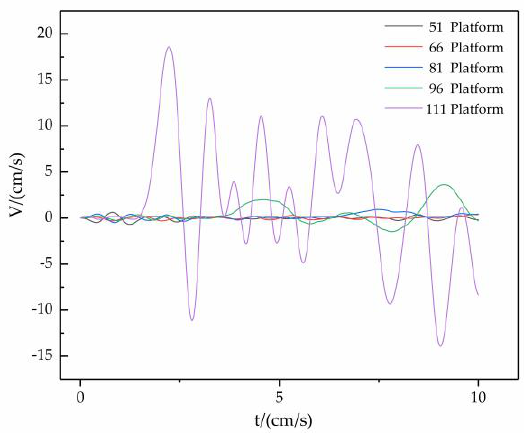
Figure 7. 10 ms blasting vibration velocity diagram of the 51–111 platform.